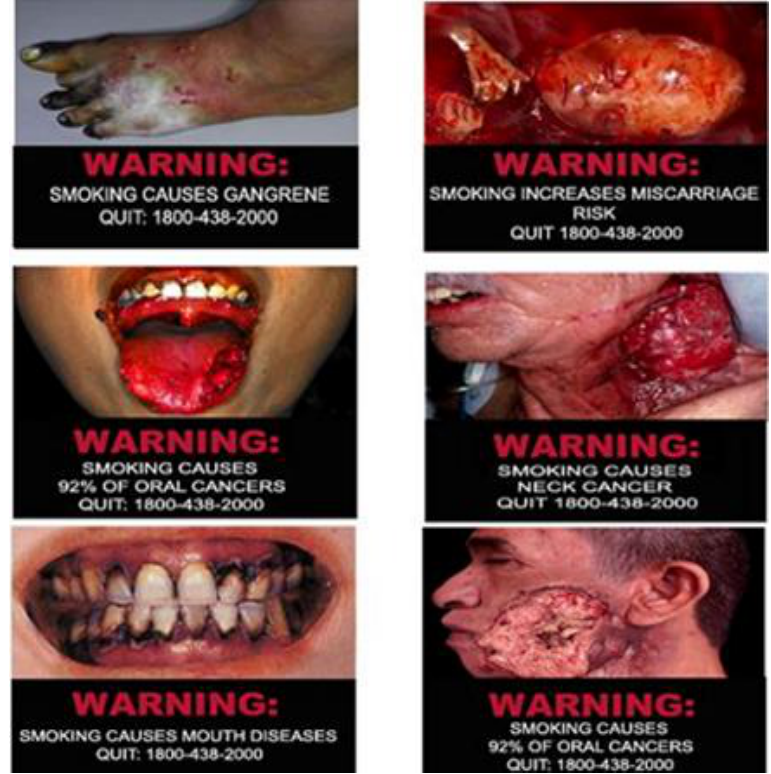
Figure 19. Lesions caused by using various kinds of paan that contain tobacco